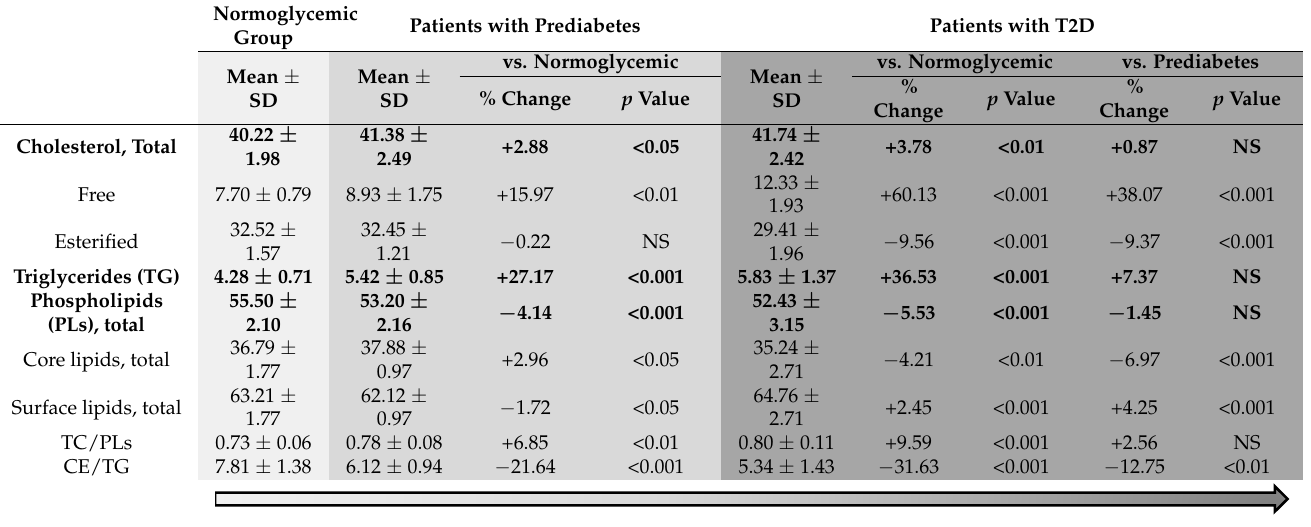
Table 2. HDL composition of major lipid classes.